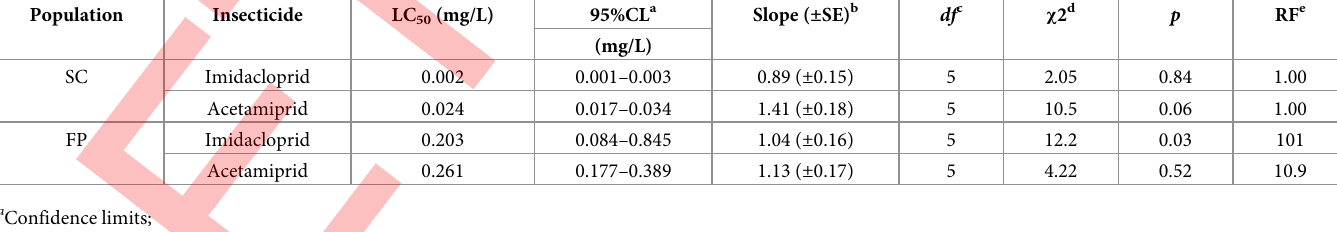
Table 2. Dose-response toxicity bioassay of imidacloprid and acetamiprid to susceptible clone (SC) and field population (FP). Population